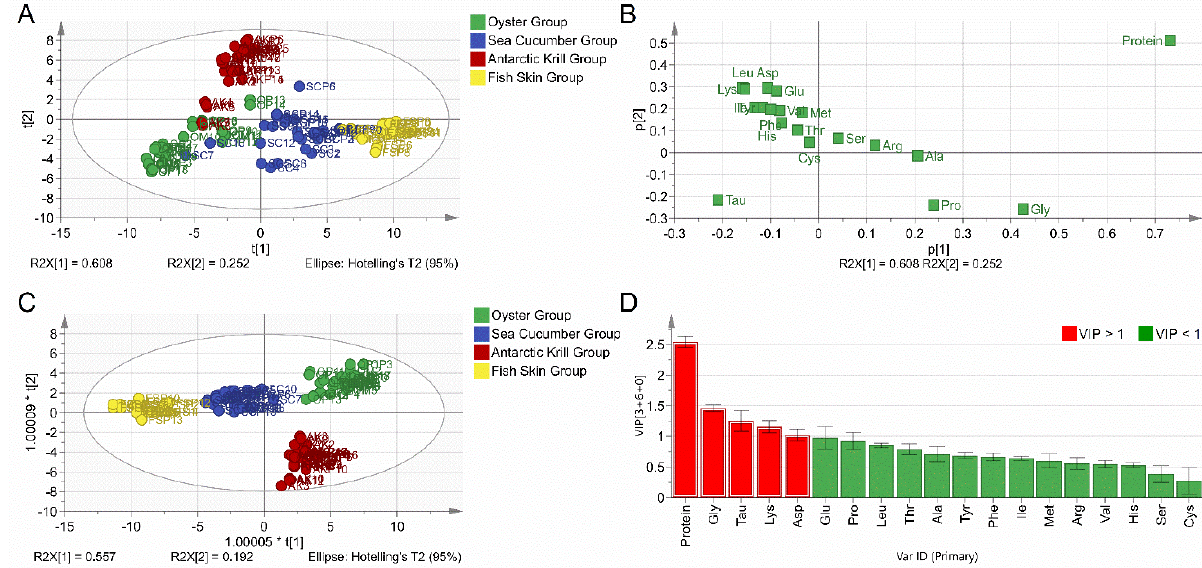
Figure 2. Chemometric analysis for the marine-derived peptides combined with the respective raw materials. ( A ) Score plot of the PCA model. ( B ) Loading plot of the PCA model. ( C ) Score plot of the OPLS–DA model. ( D ) VIP plot of the OPLS–DA model.